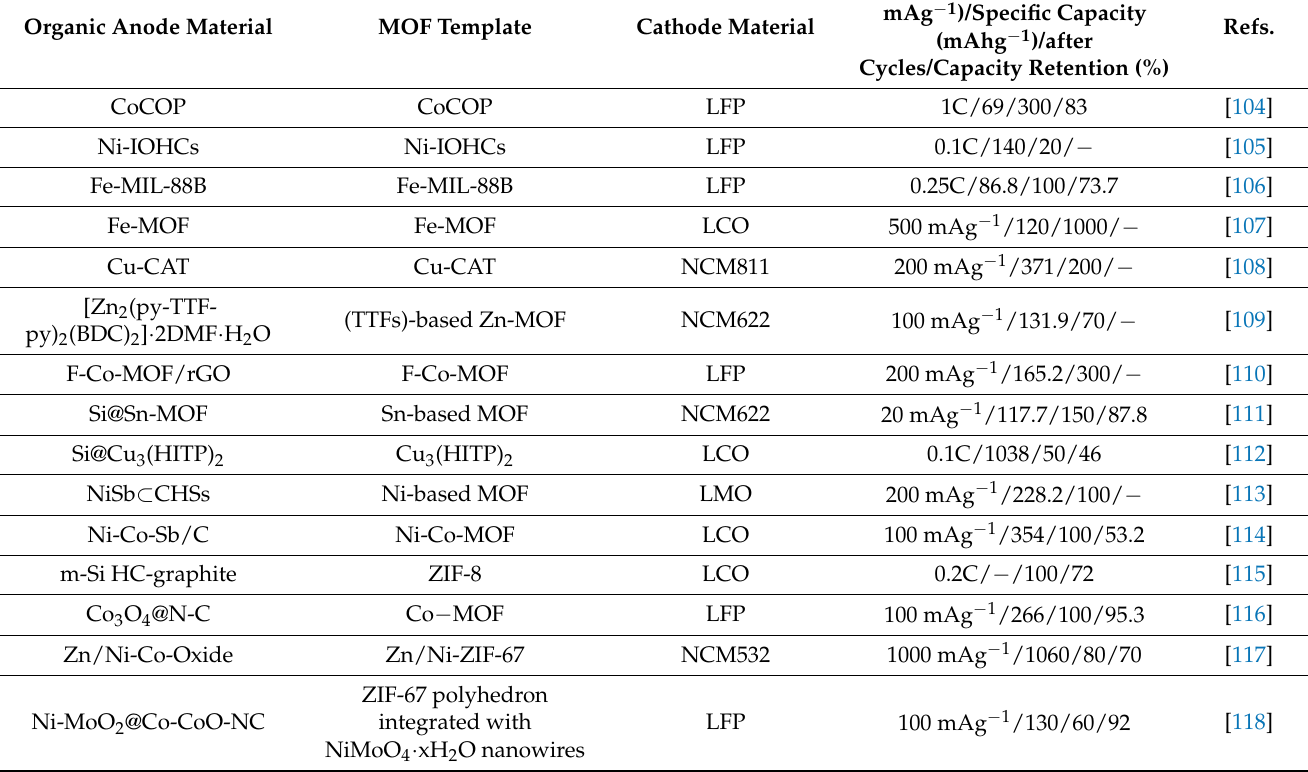
Table 3. Summary of the main electrochemical performance of Li-ion full cells assembled with MOF-based anode